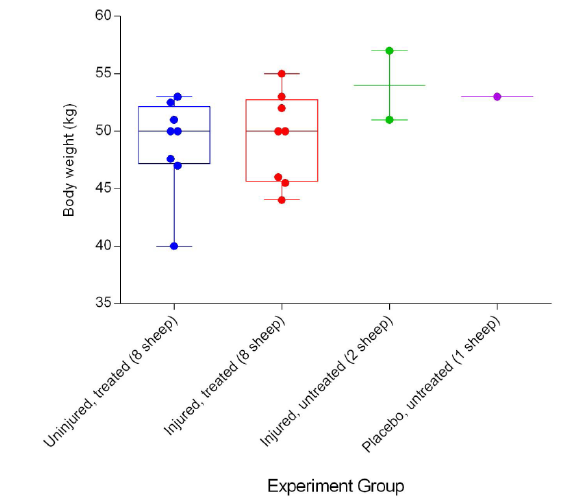
Figure 1. Body weights (Mean ± SD) of smoke and non-smoke injured sheep that received extracorporeal life support (ECLS) as compared to those of untreated